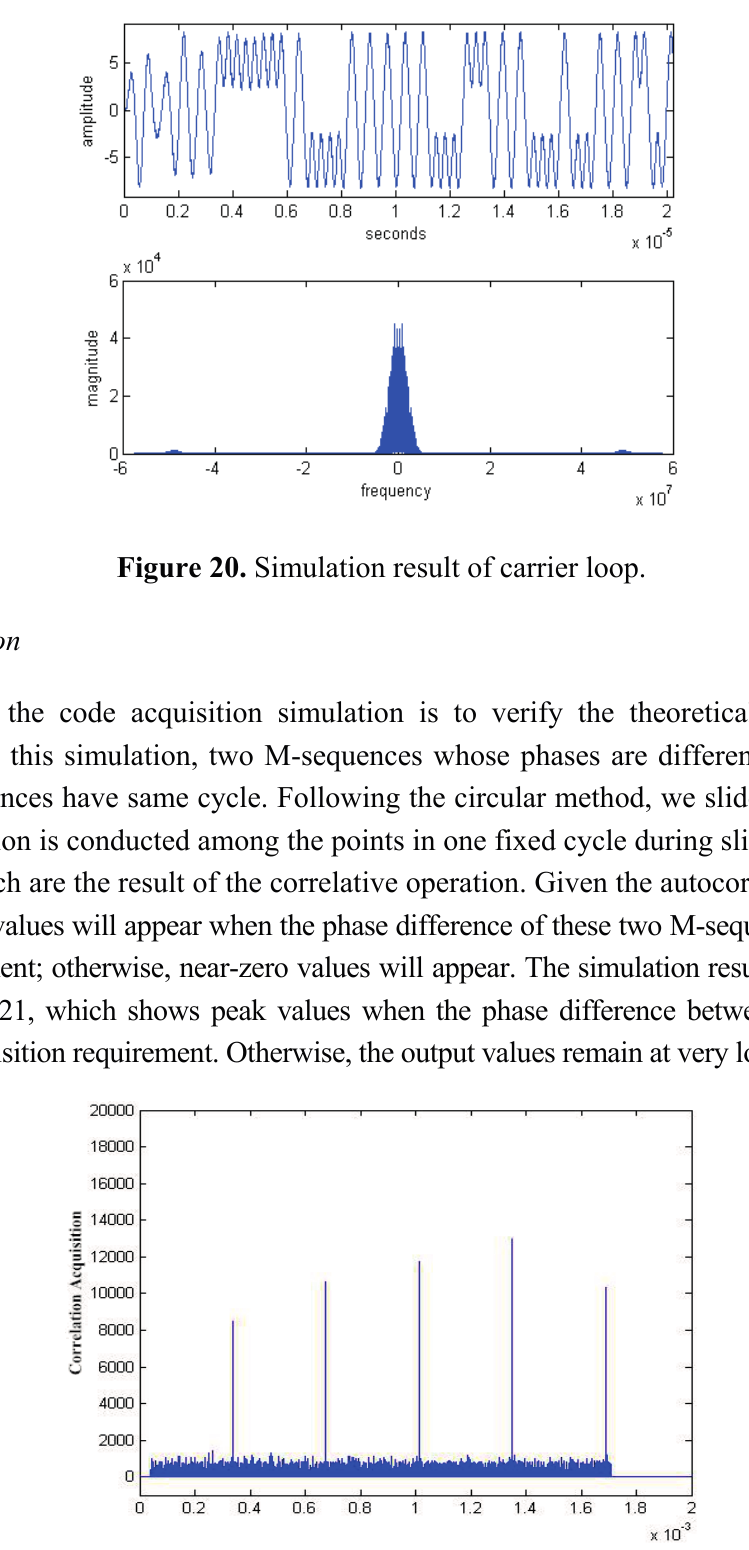
Figure 21. Simulation result of code